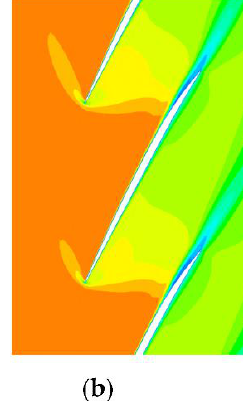
Figure 22. Comparison of Mach number contours of B2B views at T/4 moment. ( a ) DIS case; ( b ) COUP case.